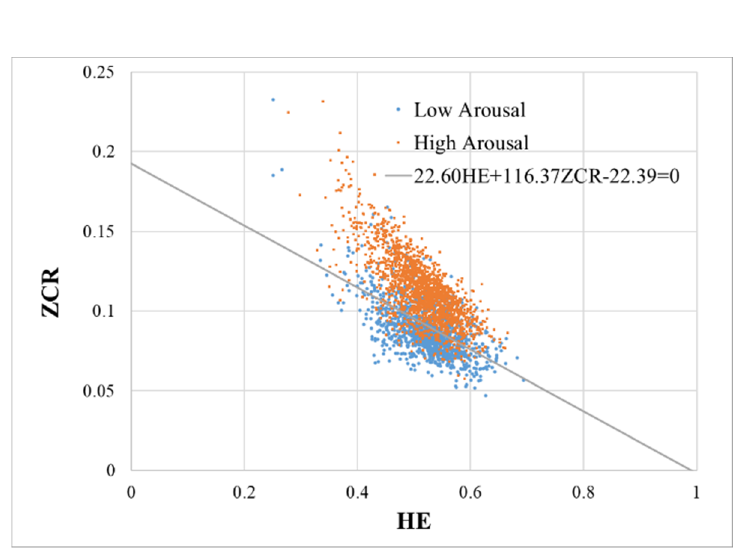
Figure 1. A scatter plot between Hurst exponent and zero-crossing rate calculated from the utterances in the Interactive Emotional Dyadic Motion Capture database. Each data point represents data for each utterance. The low arousal level data are shown in blue and the high arousal level data are shown in orange. (Note. ZCR: zero-crossing rate; HE: Hurst exponent; IEMOCAP: Interactive Emotional Dyadic Motion Capture).